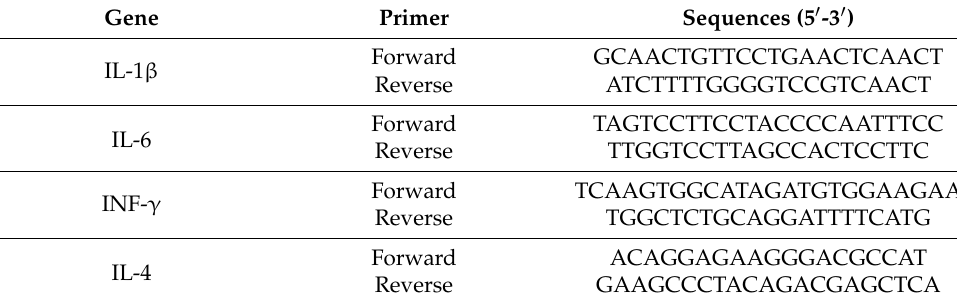
Table 2. Primer sequences for